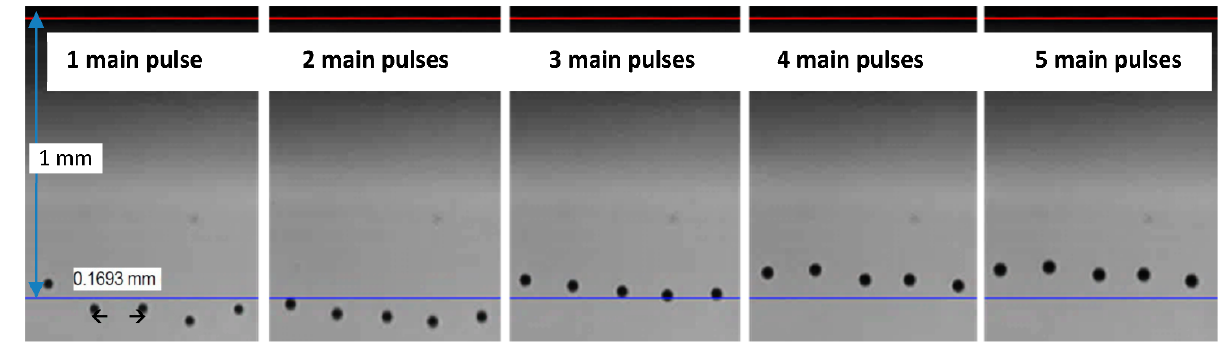
Figure 9. Droplet shape for edible ink using modified W waveform.